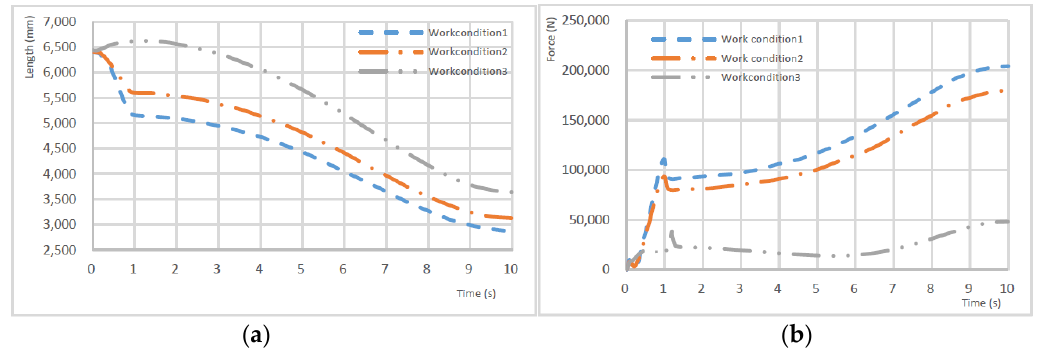
Figure 6. Simulation of secondary cylinder under three typical work conditions. ( a ) The end of the secondary cylinder trajectory; ( b ) Secondary cylinder force. secondary cylinder trajectory; ( b ) Secondary cylinder force. Table 2. The comparison of luffing parameters of main and secondary cylinder. Table 2. The comparison of luffing parameters of main and secondary